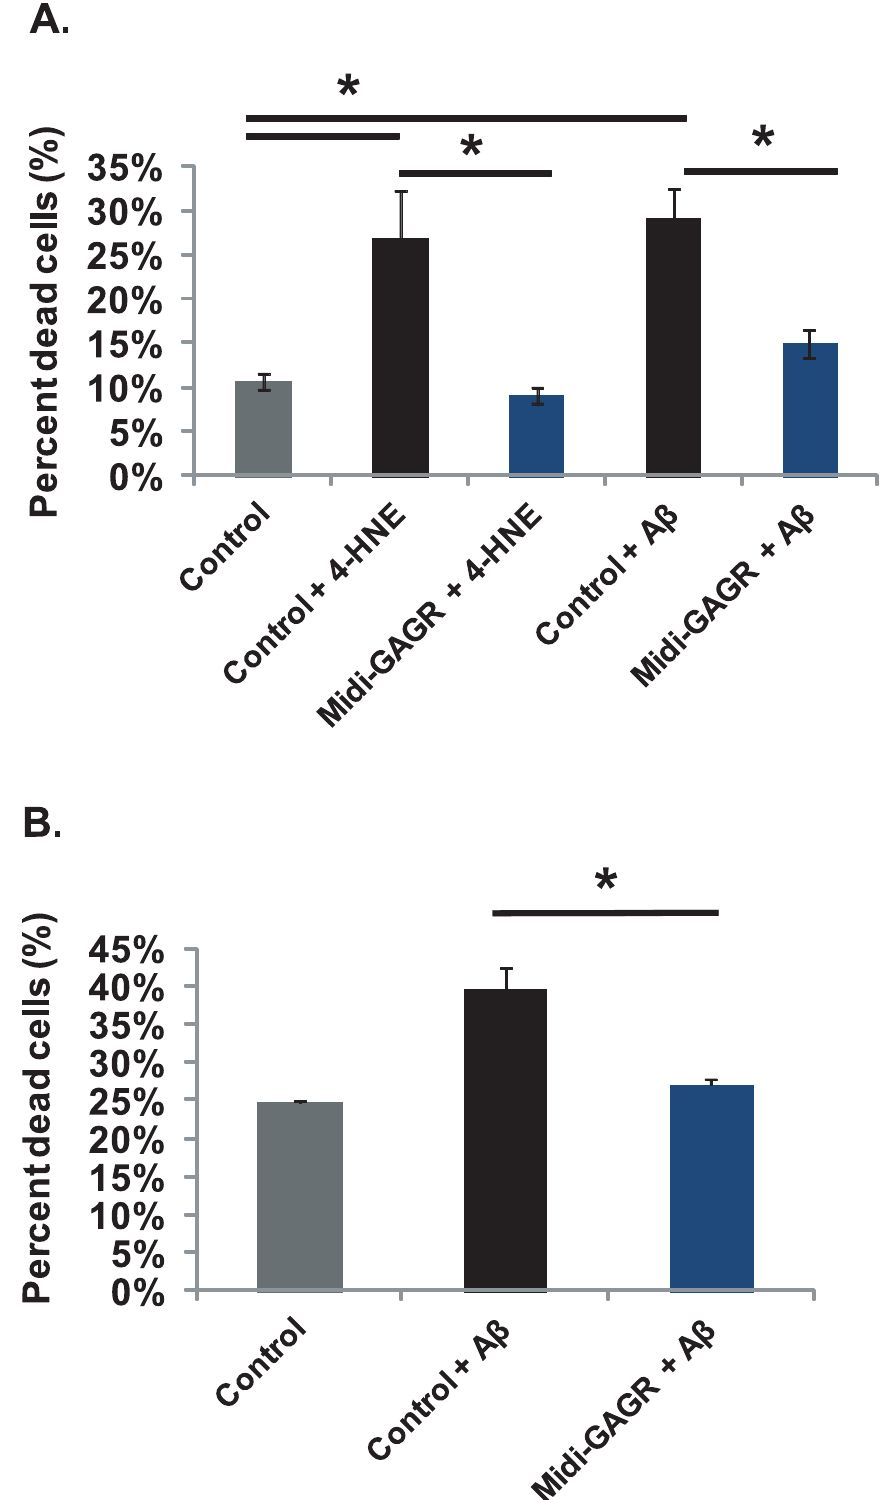
Fig 5. Midi-GAGR protects rodent cortical neurons from co-treated 4HNE, A β 42 peptide and activated microglial cells. (A) Rat cortical neurons (E17) at DIV5 were co-treated with either 10 μ M 4HNE (for 24 h)